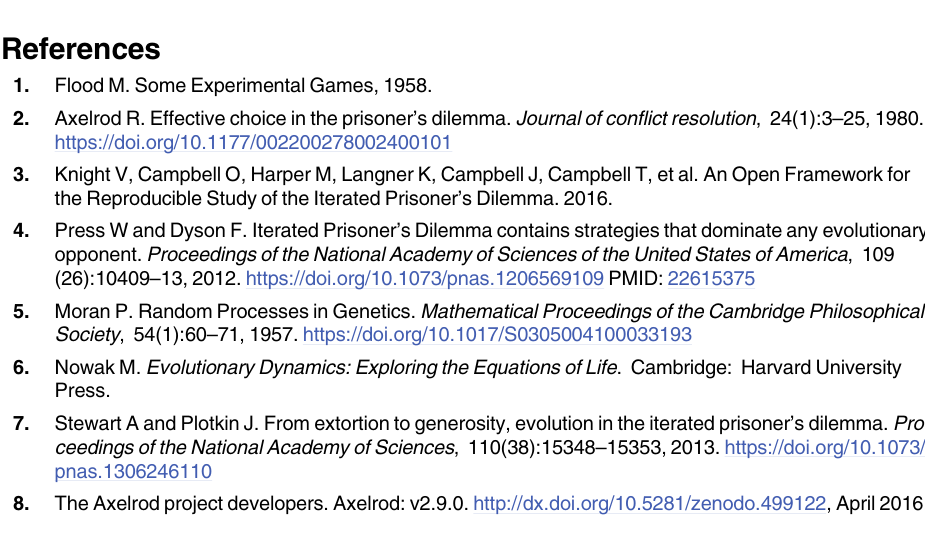
S23 Fig. The fixation probabilities x S24 Fig. The fixation probabilities x